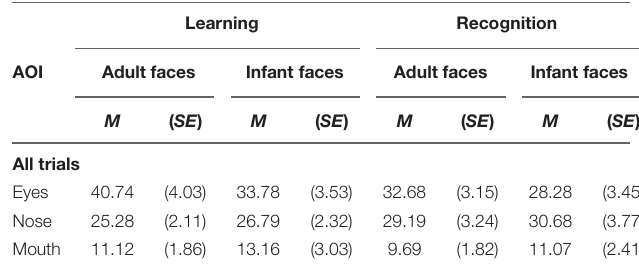
TABLE 2 | Mean and standard error of the percentage of total looking time on each of the three AOI (eyes, nose, mouth) on the adult and infant face during learning and recognition